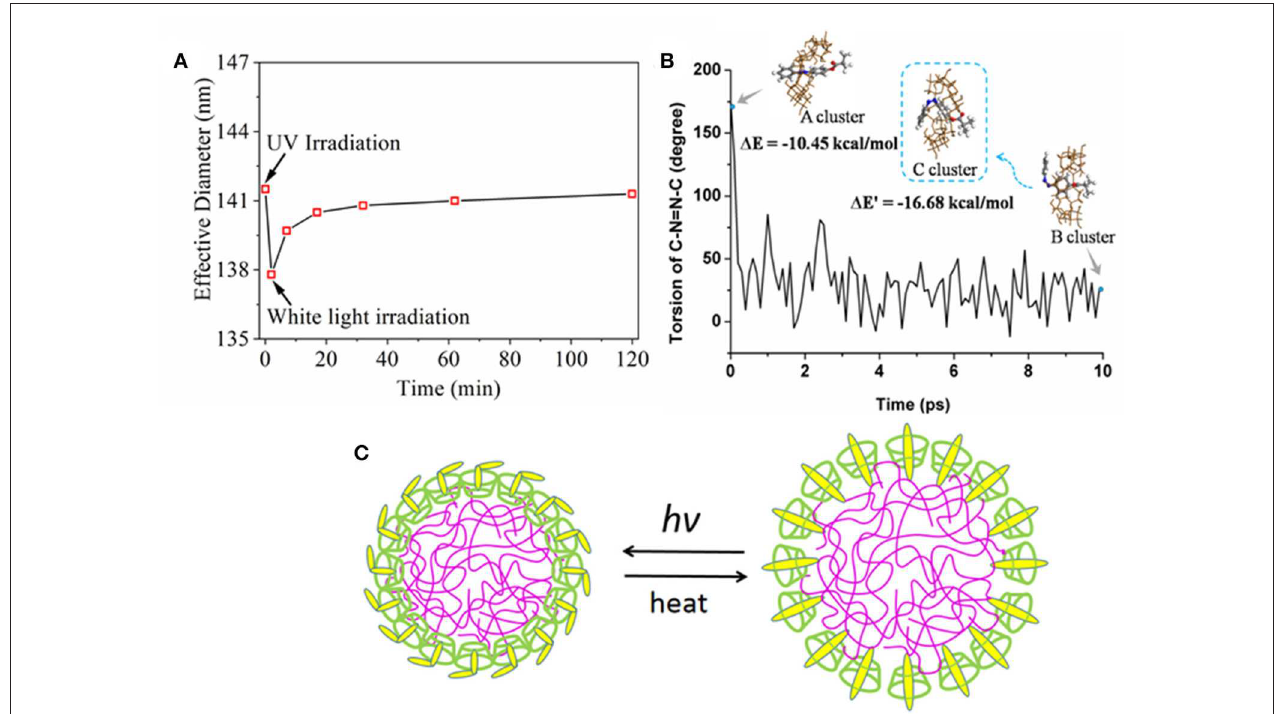
FIGURE 4 | (A) Effective diameter as a function of irradiation time and recovery time; (B) Torsion of C-N = N-C (degree) of AZO evolved by dynamics time (ps) carried out by MS program. The insets of A cluster was the optimized structure of trans-AZO and β -CD by G09 package, meanwhile the intial structure of our simulation; B cluster was the final structure of the simulation; and C cluster was the optimized structure of cis-AZO and β -CD cluster from B cluster; (C) Proposed UV response mechanism for assembled nanoparticle.